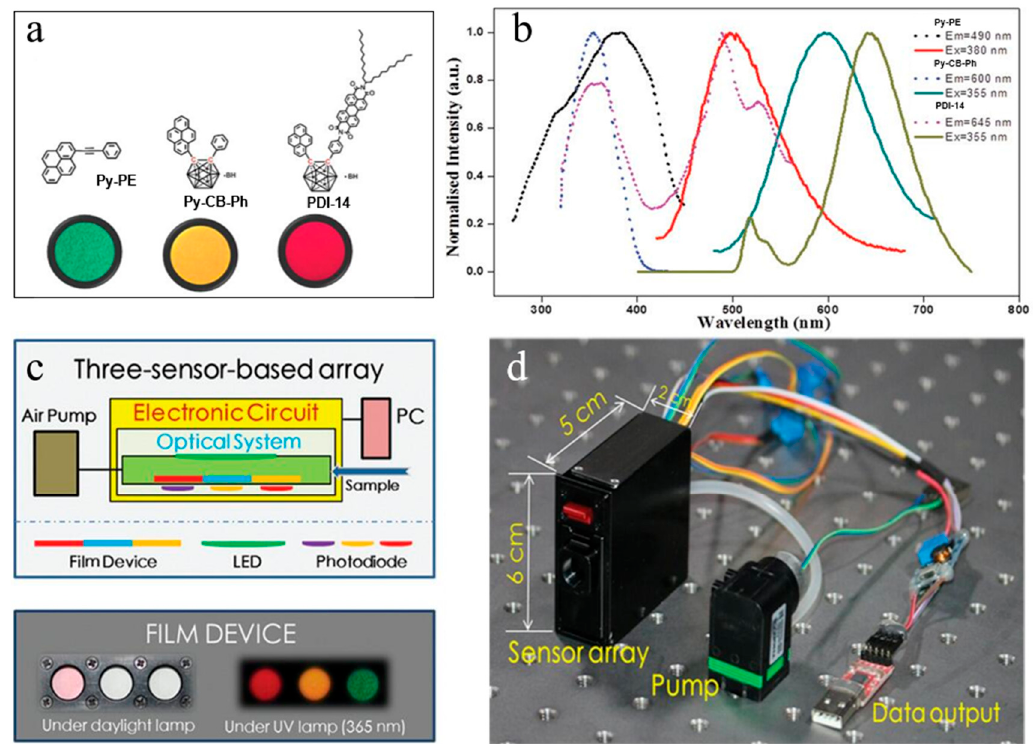
Figure 15. ( a ). Molecular structures of the three synthesized fluorophores (Py-PE, Py-CB-Ph, and PDI-14) and photographs taken over the corresponding films under UV light (365 nm) showing different emission colors; ( b ) . The excitation and emission spectra of the films fabricated from the three molecules; ( c ). Schematic illustration of the detector platform based on an array of sensors (films) fabricated from the three molecules, with the daylight and fluorescence photographs of the three films shown I the bottom panel; ( d ). Photograph of the real detector system consists of different parts [83].